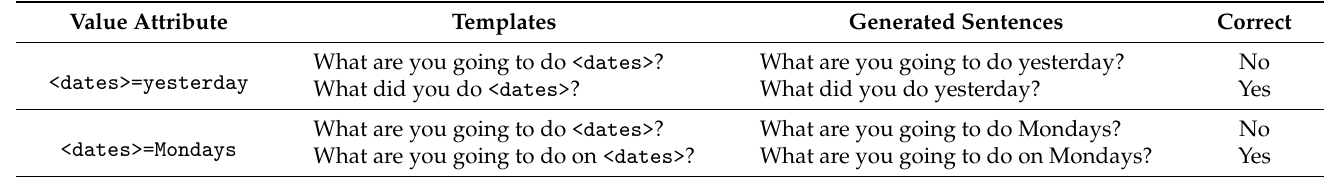
Table 4. Examples of sentences selected via Transformer